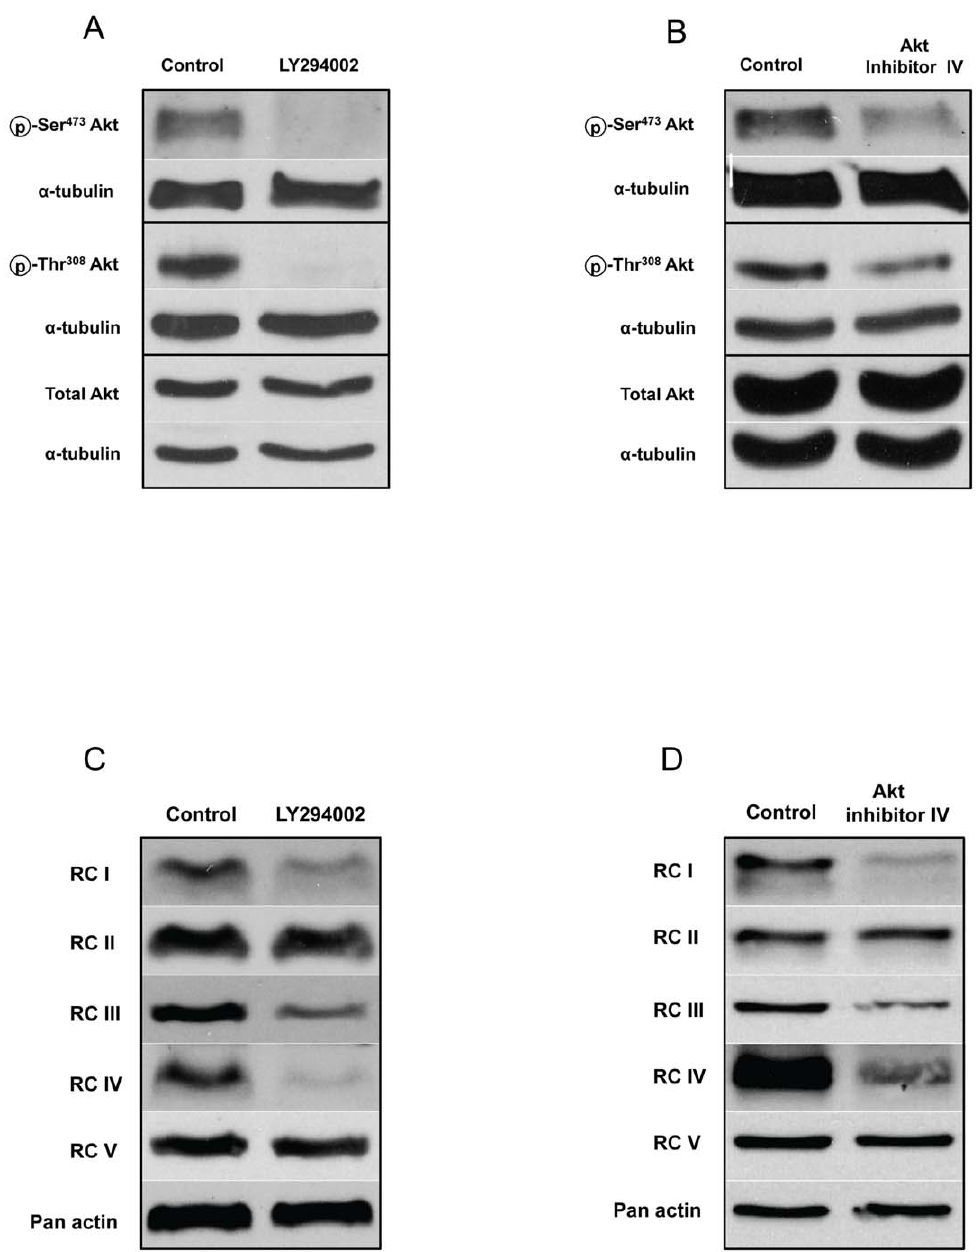
Figure 4. Effects of LY294002 and Akt inhibitor IV on MEF PTEN 2 / 2 . MEF PTEN 2 / 2 were exposed to 25 m M LY294002 for 4 h or 1 m M Akt inhibitor IV for 8 h. ( A, B ) Western blot analyses of p-Ser 473 Akt, p-Thr 308 Akt and total Akt Expressions of p- Ser 473 Akt, p-Thr 308 Akt were compromised by LY and Akt inhibitor IV, respectively, while total Akt remained relatively unchanged. ( C, D ) Western blots of respiratory complexes Protein expressions of respiratory complexes I, III and IV were down regulated by LY and Akt inhibitor IV. Those of RCII and RCV appeared to be